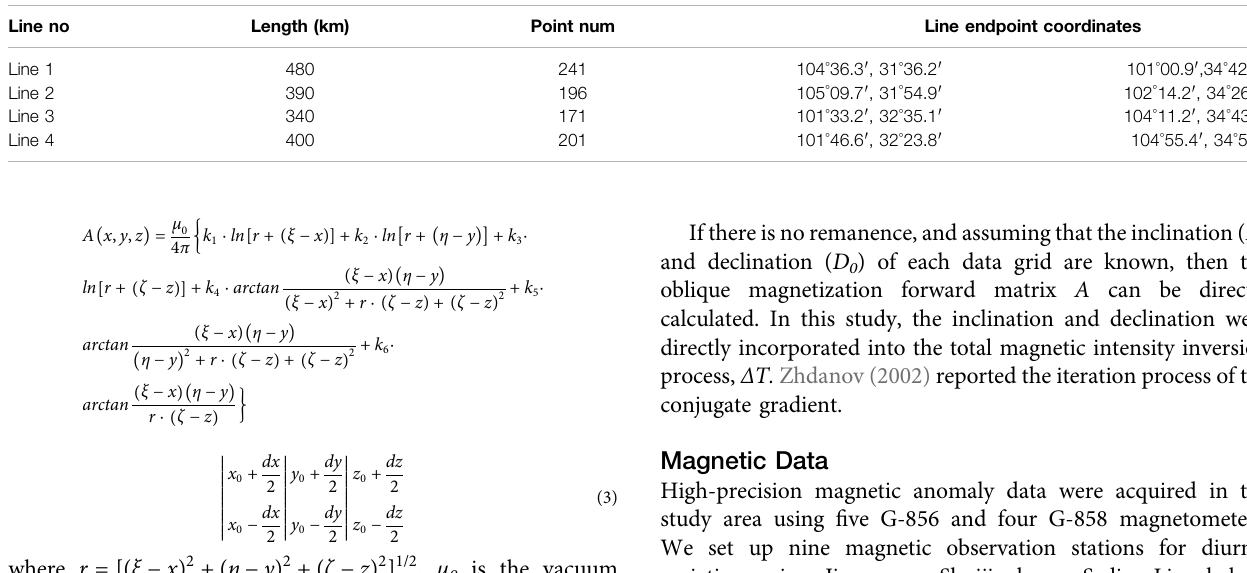
TABLE 2 | MT pro fi le workload